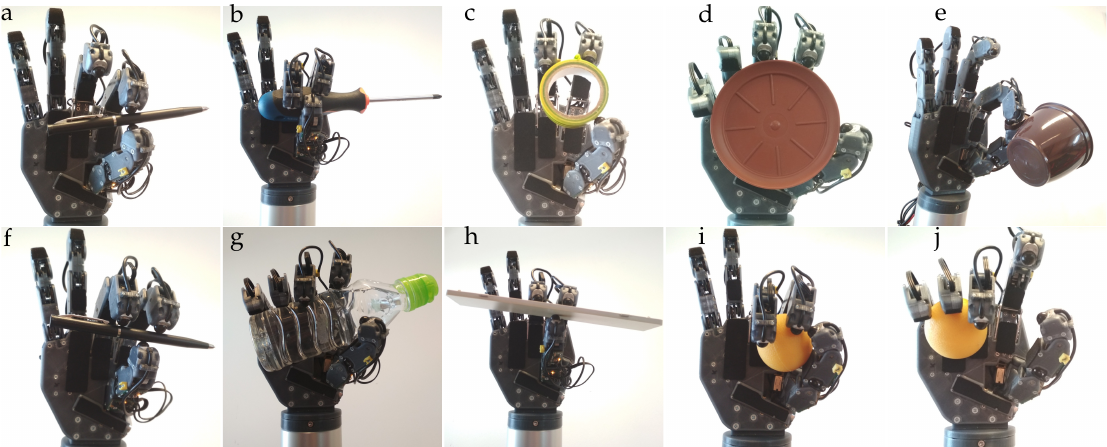
Figure 15. Sample configuration of PUT-Hand during grasping of various objects. Examples of precise grasps ( a , c – f , h ), and power grasps ( b , g , i , j ).